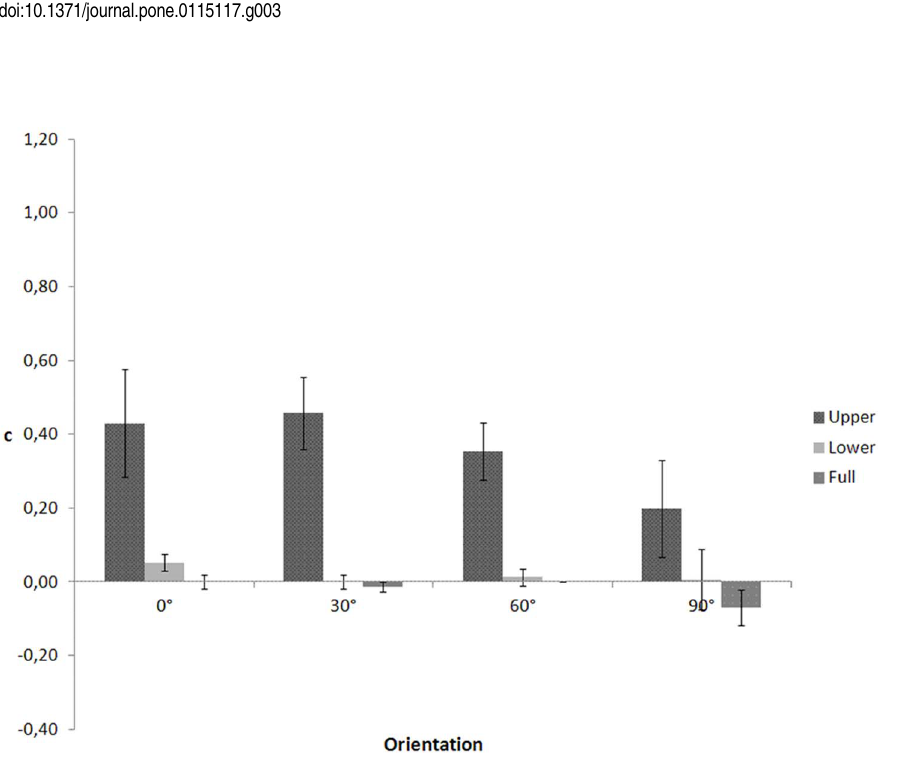
Fig. 4. c as a function of visible body part and figure orientation for the walking action in Experiment